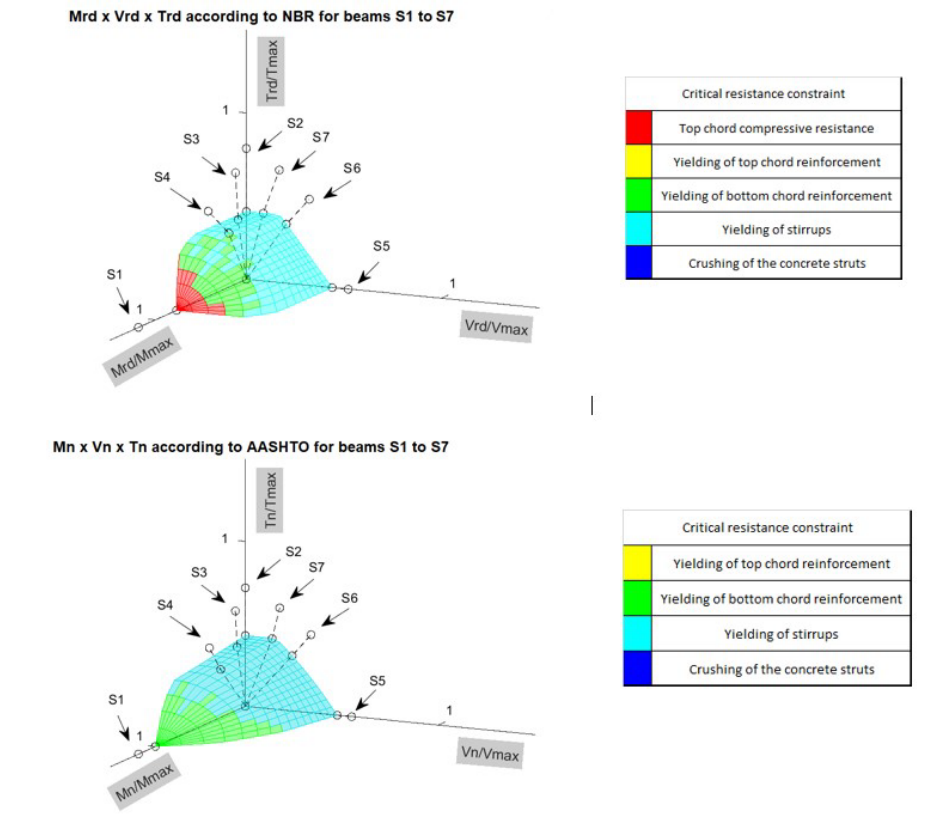
Figure 20: Interaction surface according to NBR and AASHTO for beams S1-S7.